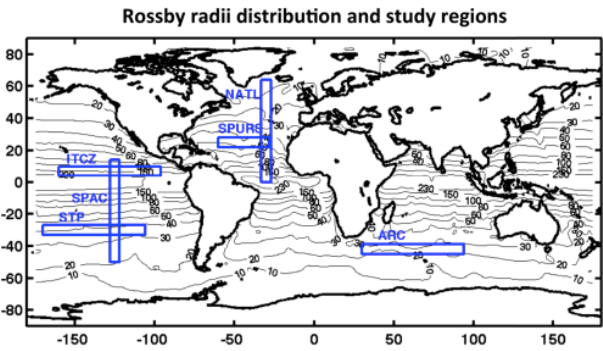
Figure 5. Spatial distribution of Rossby radii of deformation, from Hoareau et al. (2018b). Blue boxes are the regions where the power density spectra and singularity power spectra are computed: NATL (North Atlantic) [0–64 ◦ N, 27–33 ◦ W], Intertropical Convergence Zone (ITCZ) [4–10 ◦ N, 96–160 ◦ W], SPURS (region of the oceano- graphic campaign Salinity Processes in the Upper-ocean Regional Study) [22–28 ◦ N, 28–60 ◦ W], ARC (Agulhas Current Retroflec- tion) [39–45 ◦ S, 30–94 ◦ E], STP (south tropical Pacific) [27–33 ◦ S, 106–170 ◦ W], and SPAC (southern Pacific) [14 ◦ N–50 ◦ S, 122– 128 ◦